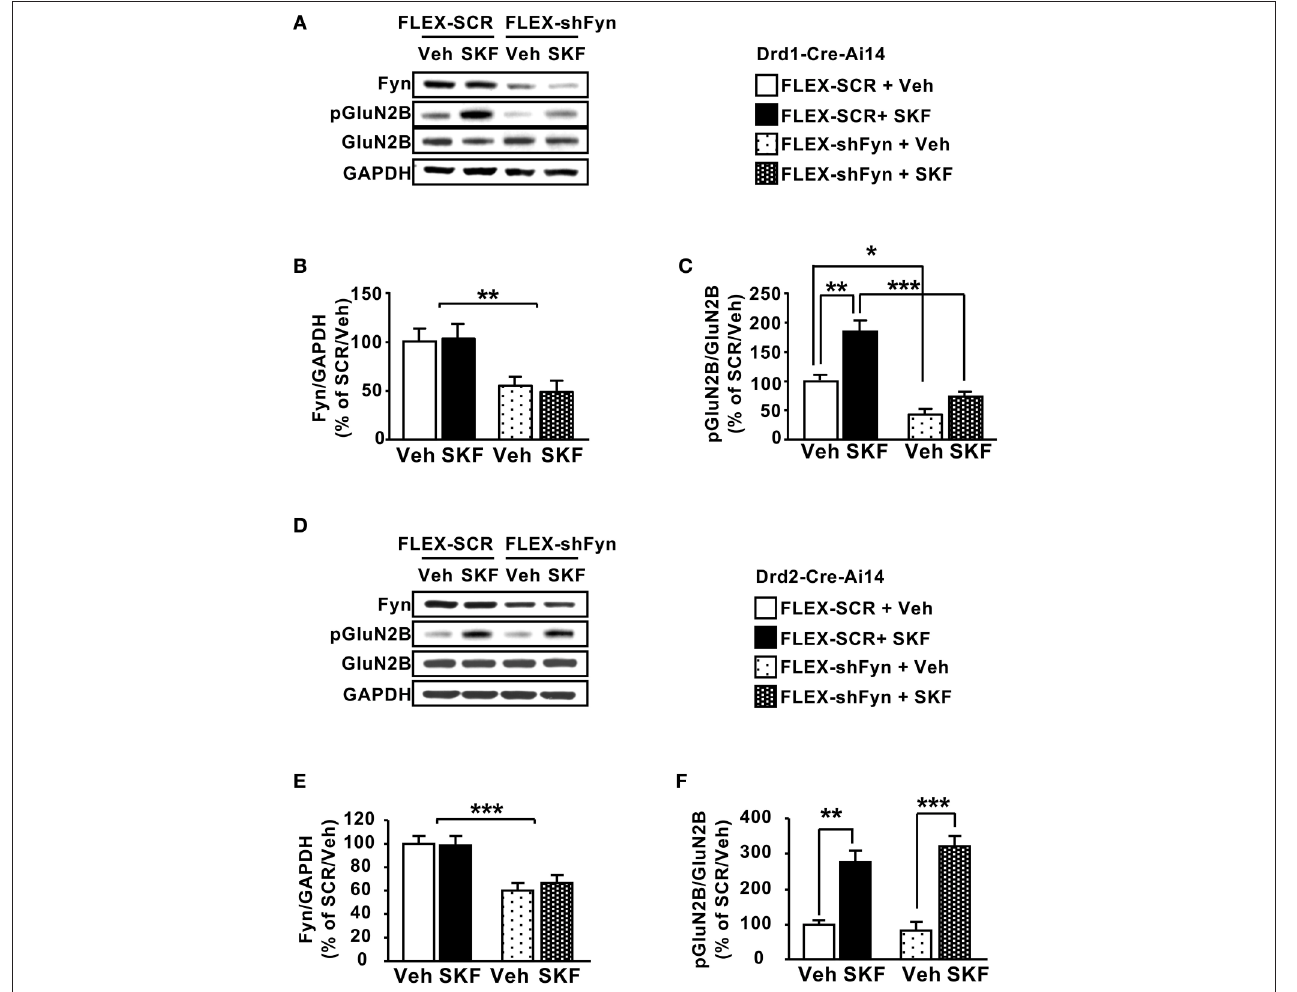
FIGURE 5 | Knockdown of Fyn in DMS D1R but not in D2R neurons attenuates SKF81297-dependent GluN2B phosphorylation. (A–C) The DMS of Drd1-Cre-Ai14 mice (A–C) or Drd2-Cre-Ai14 (D–F) was infected with Ltv-FLEX-shFyn or Ltv-FLEX-SCR (2 × 10 7 pg/ml). Four weeks later and 15 min before the dissection, animals